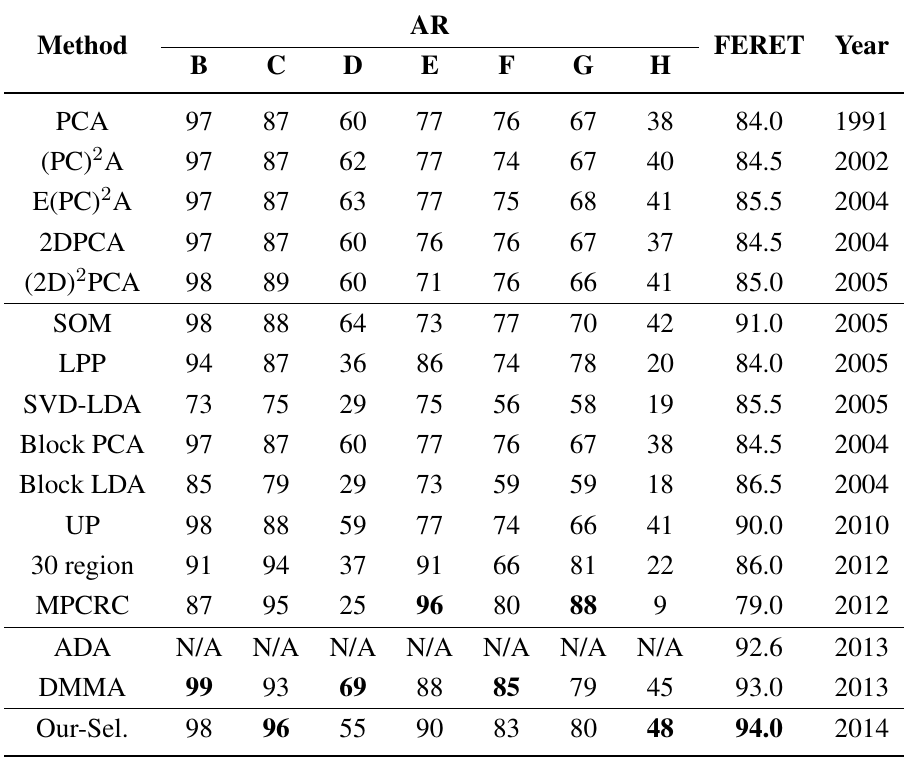
Table 4. Evaluation of the AR and FERET-2 databases for single sample per person (SSPP) face recognition. DMMA, discriminative multi-manifold analysis; ADA, adaptive discriminant